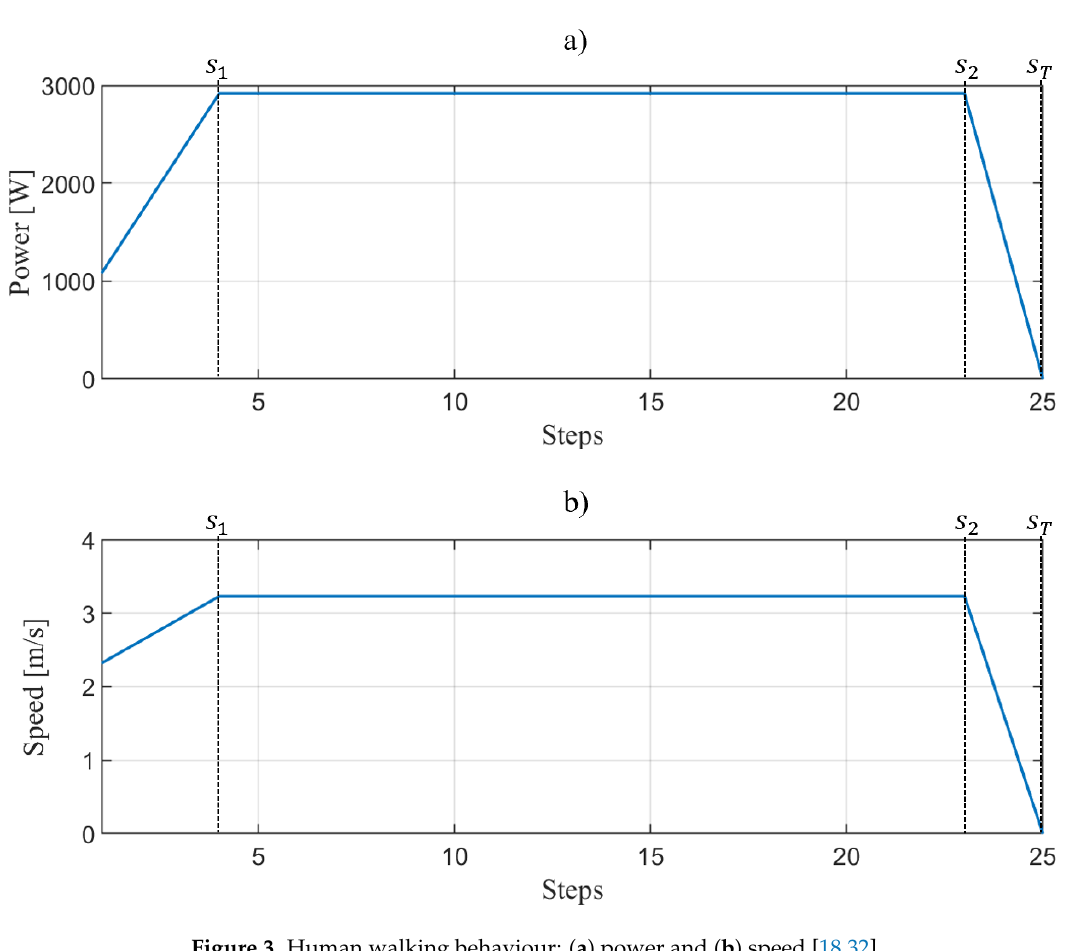
Figure 3. Human walking behaviour: ( a ) power and ( b ) speed